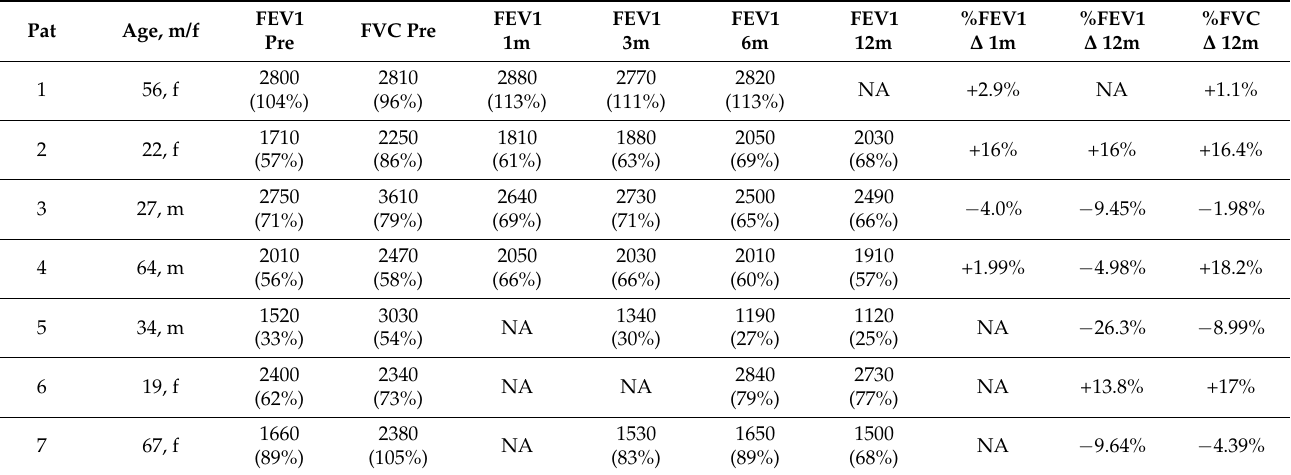
Table 1. Non-vaccinated lung transplant recipients with mild and moderate COVID.